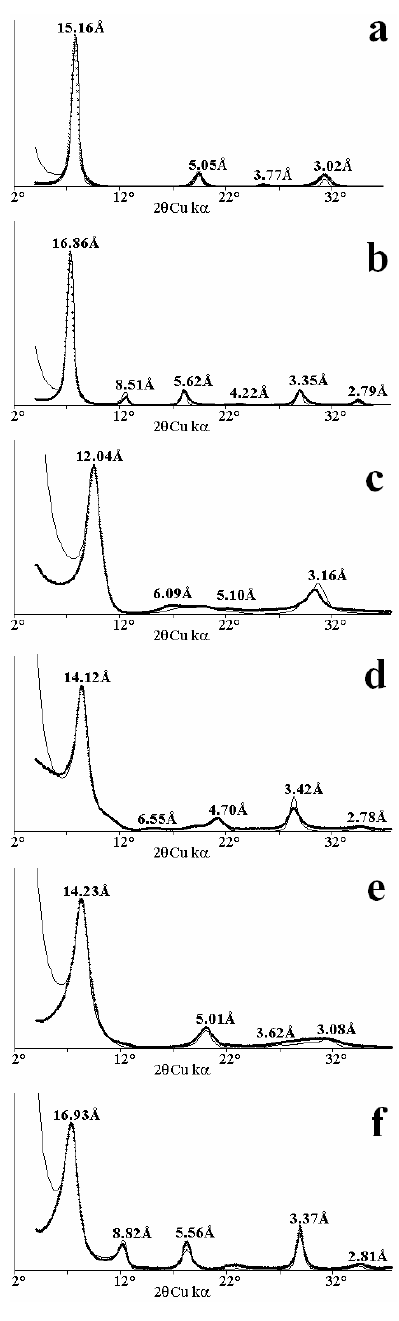
Fig. 2–ExperimentalandcalculatedXRDpatternsfromoriented preparations of sample 8 (1.55m depth). a) Ca-saturated sample in the AD state. b) Ca-saturated sample in the EG state. c) K- saturated sample in the AD state. d) K-saturated sample in the EG state. e) K-Ca-saturated sample in the AD state. f) K-Ca- saturated sample in the EG